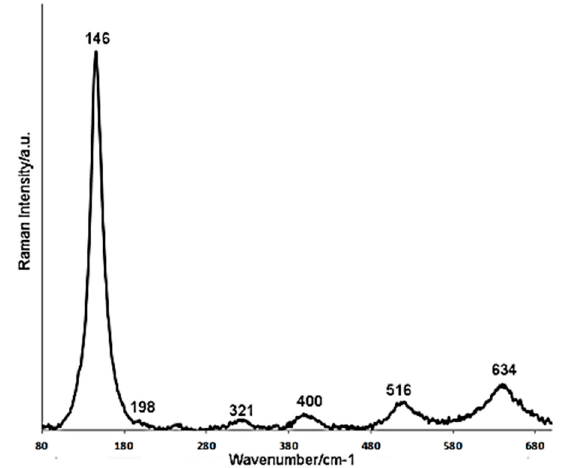
Figure 2. Representative Raman spectrum of TiO 2 -coatings. Example of anatase Raman spectrum collected from the thin film deposited on a 3TS sample.